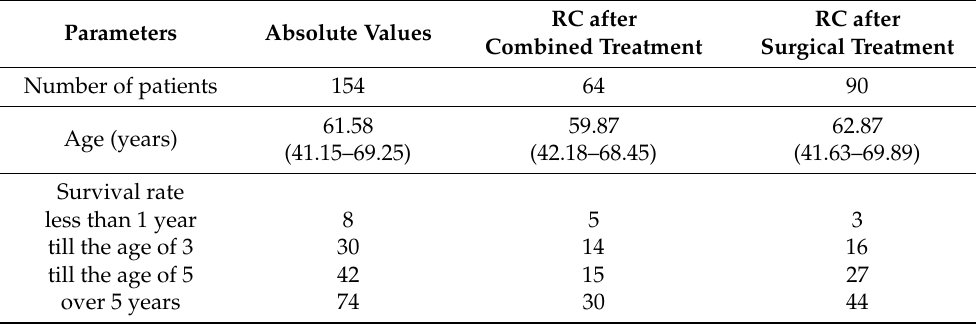
Table 1. Characteristics of patients with